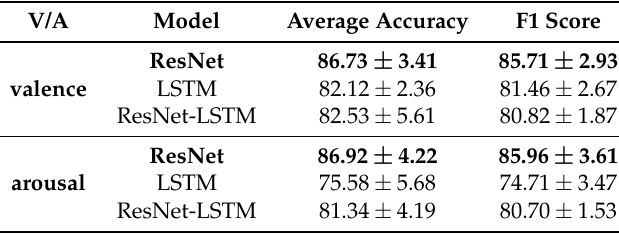
Table 9. The comparison of ResNet, LSTM, and Hybrid ResNet-LSTM model for valence and arousal. Accuracies (%) and F1 score (%) are subject to 10-fold cross validation. The best results are highlighted in bold.